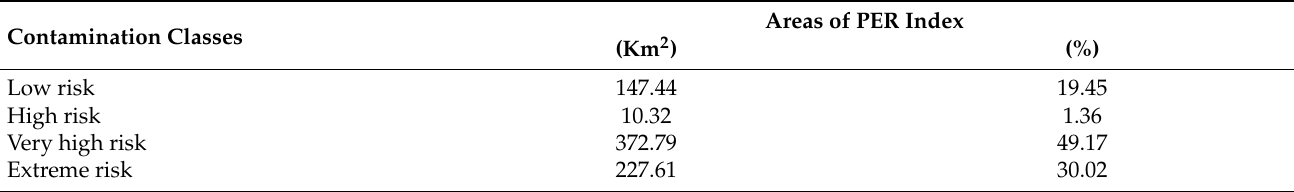
Table 5. Areas and contamination classes for the PER